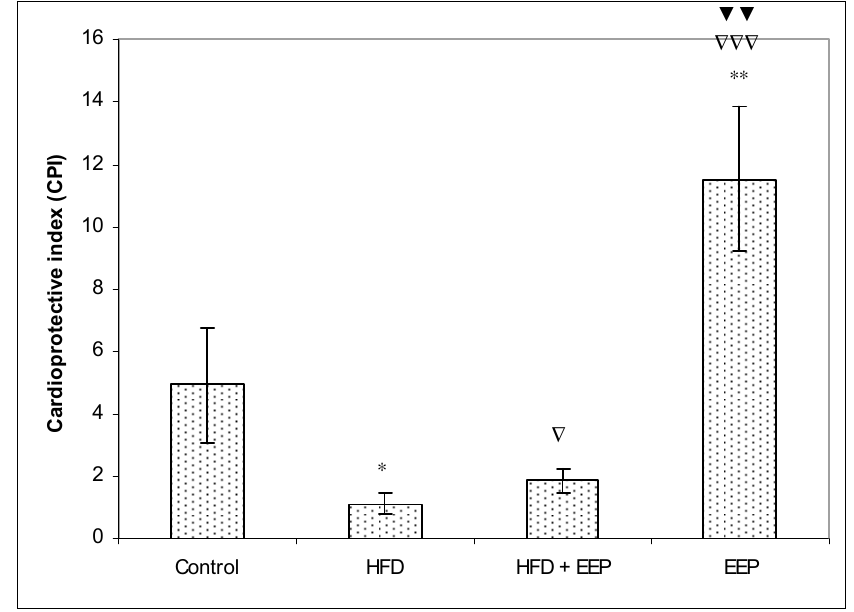
∇∇ ▼ Figure 7. Effect of ethanol extract of propolis on cardiac risk ration (CRR). Mice were given HFD,